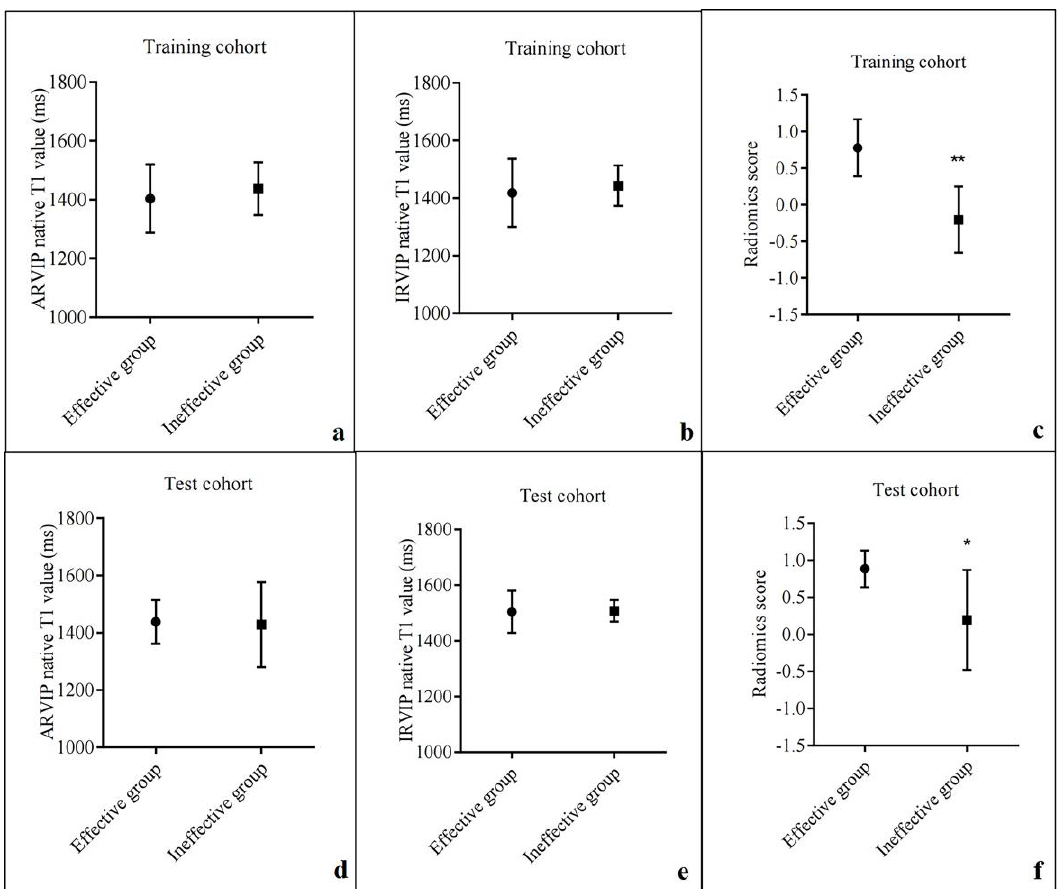
Figure 3. Mean values with error bars for ARVIP, IRVIP and radiomics scores in training and test cohorts. The centers represent the mean values, and the bars denote standard value (SD). ** p < 0.001; * p < 0.05. ( a – c ). Comparison of the native ARVIP T1 value ( a ), native IRVIP T1 value ( b ) and radiomics score ( c ) between effective group and ineffective group in training cohort. ( d – f ). Comparison of